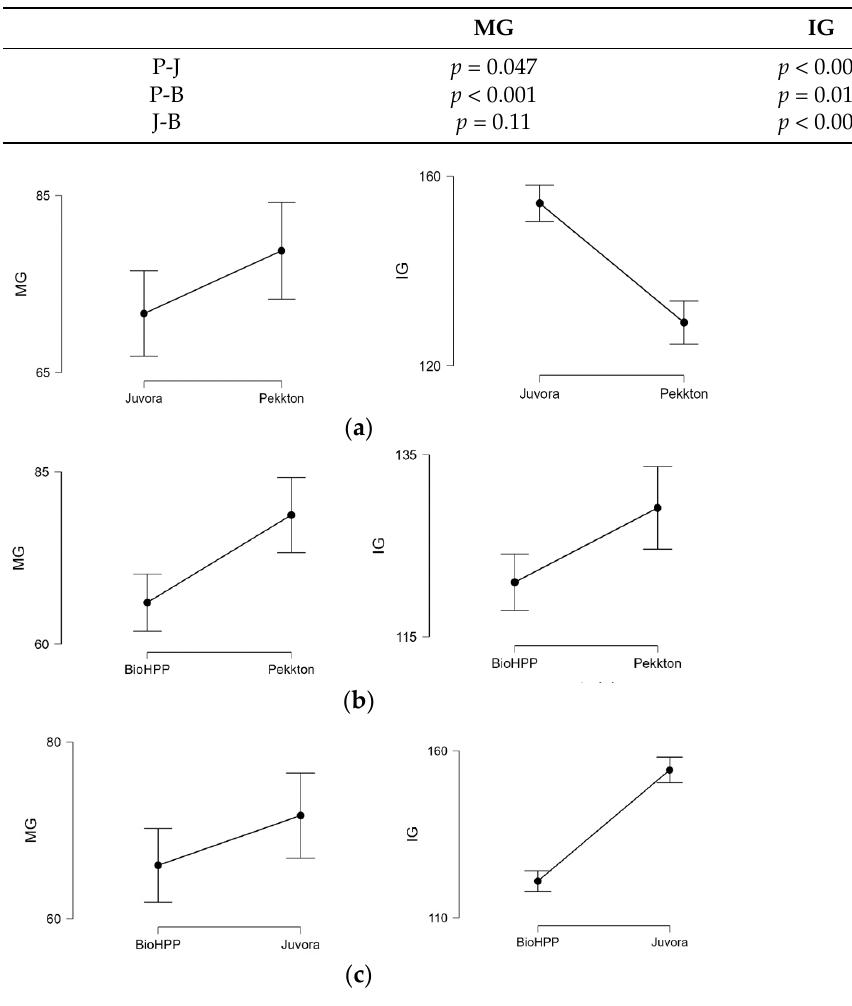
Figure 7. Descriptive plots for MG and MG between materials: ( a ) Juvora-Pekkton; ( b ) BioHPP- Pekkton; ( c ) BioHPP-Juvora.